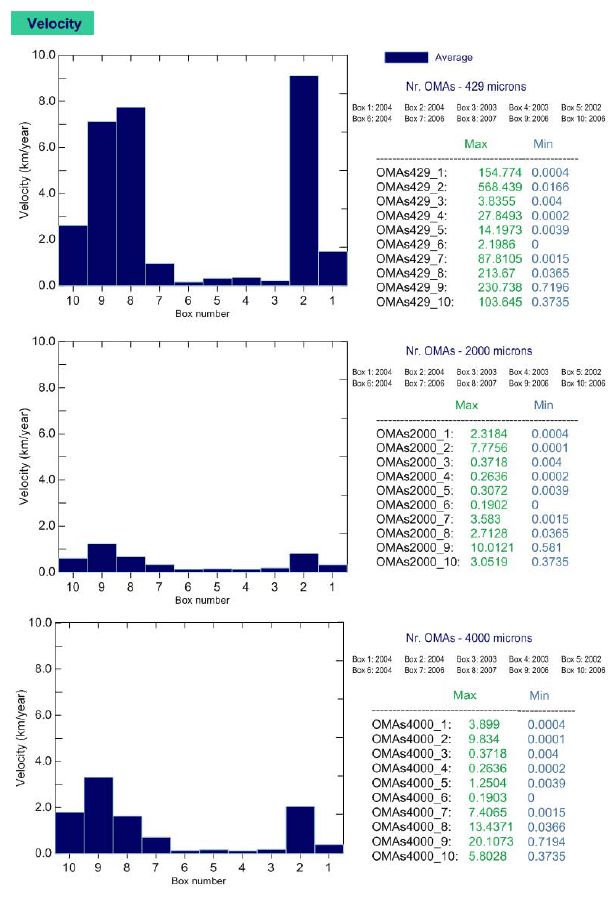
Fig. 10. Velocity predicted by the model for the three classes of